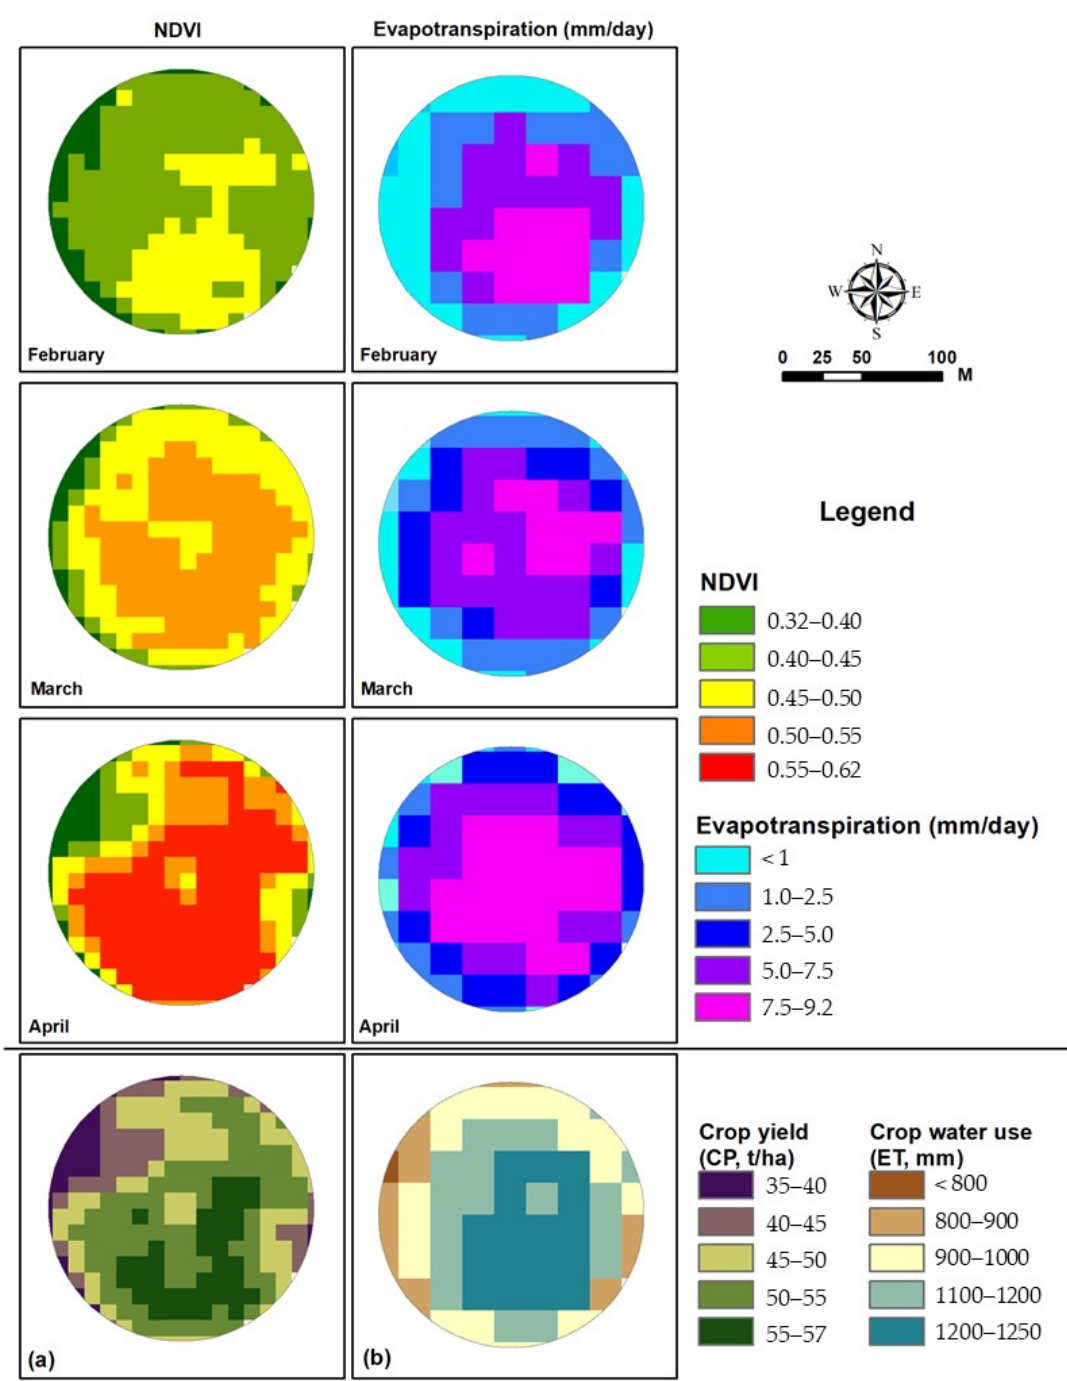
Figure 6. Monthly mean NDVI and evapotranspiration maps: ( a ) crop yield and ( b ) seasonal crop water use maps of onion